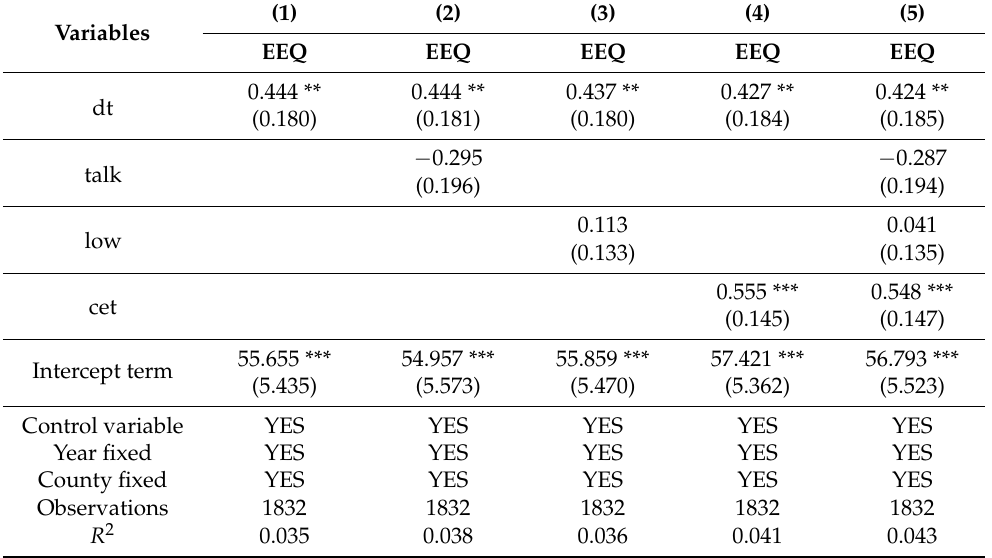
Table 8. Policy interference